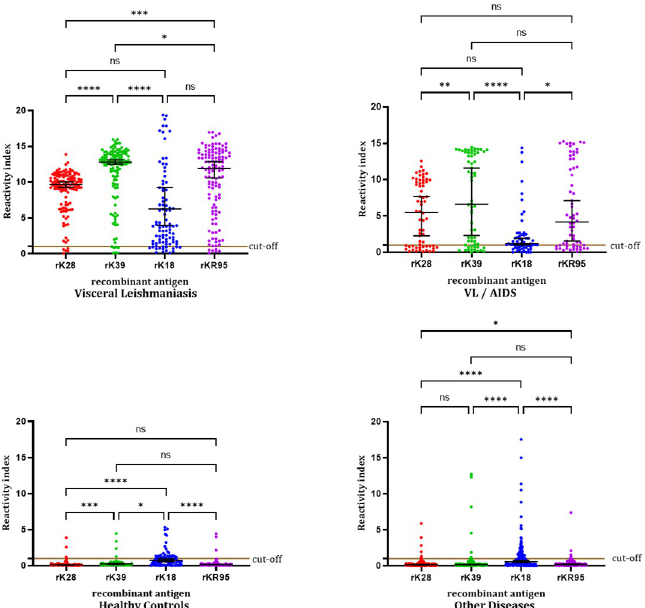
Fig 4. Reactivity indices obtained by ELISA with recombinant antigens with 122 samples from VL patients, 64 samples from VL / AIDS patients, 83 samples from healthy controls (Panel 2), and 190 samples from patients with other diseases (Panel 3). The horizontal black lines represent the median ABS% Positive Control values with a 95% confidence interval. Friedman test: p < 0.0001 (for the four groups of samples). Dunn’s multiple comparisons test: VL patients: � —p = 0.0282; ��� —p = 0.0004; ���� —p < 0.0001; ns—p = 0.2522 (rK18 x rKR95) and p = 0.3187 (rK28 x rK18). VL / AIDS patients: � —p = 0.0300; �� —p = 0.0077; ���� —p < 0.0001; ns—p = 0.6920 (rK28 x rK18), p > 0.9999 (rk28 x rKR95) and p = 0,2825 (rK39 x rKR95). Healthy controls: � —p = 0.0374; ��� —p = 0.0003; ���� —p < 0.0001; ns —p = 0.4002 (rK28 x rKR95) and p = 0.1692 (rK39 x rKR95). Other diseases patients: � —p = 0.0152; ���� —p < 0.0001; ns—p = 0.1646 (rK28 x rK39) and p > 0.9999 (rK39 x rKR95). The four antigens discriminated significantly between negative (healthy controls) and positive (VL patients) samples (Mann-Whitney test: p <